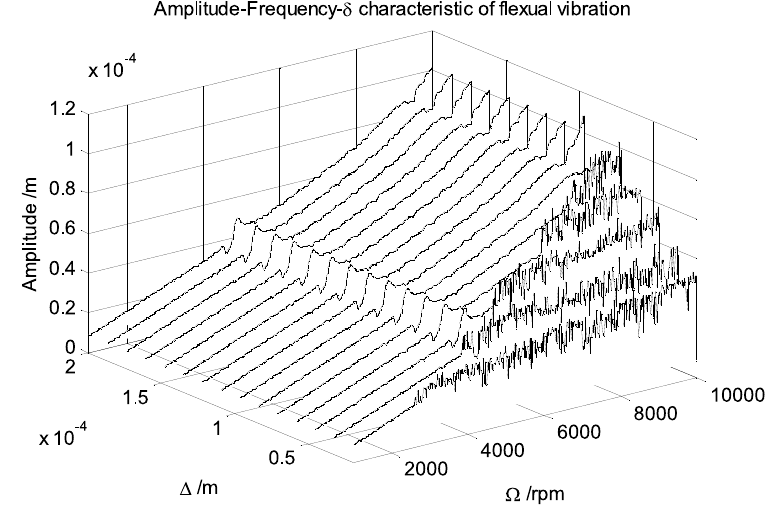
Fig. 5. Relationship of the amplitude of the flexural vibration with rotational speed and gap.